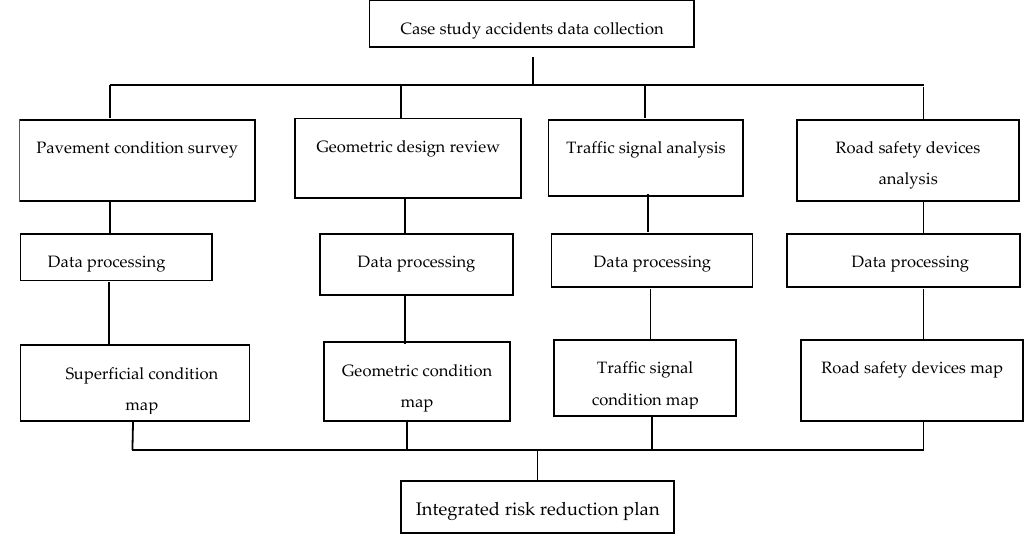
Figure 2. Methodology flowchart.